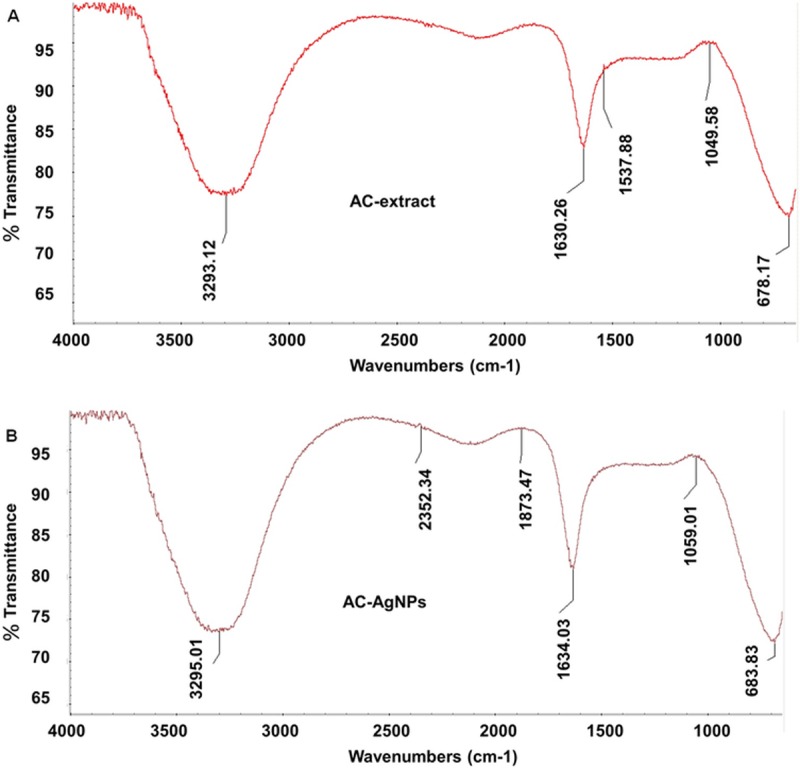
FT-IR analysis of (A) AC extract and (B) AC-AgNPs.